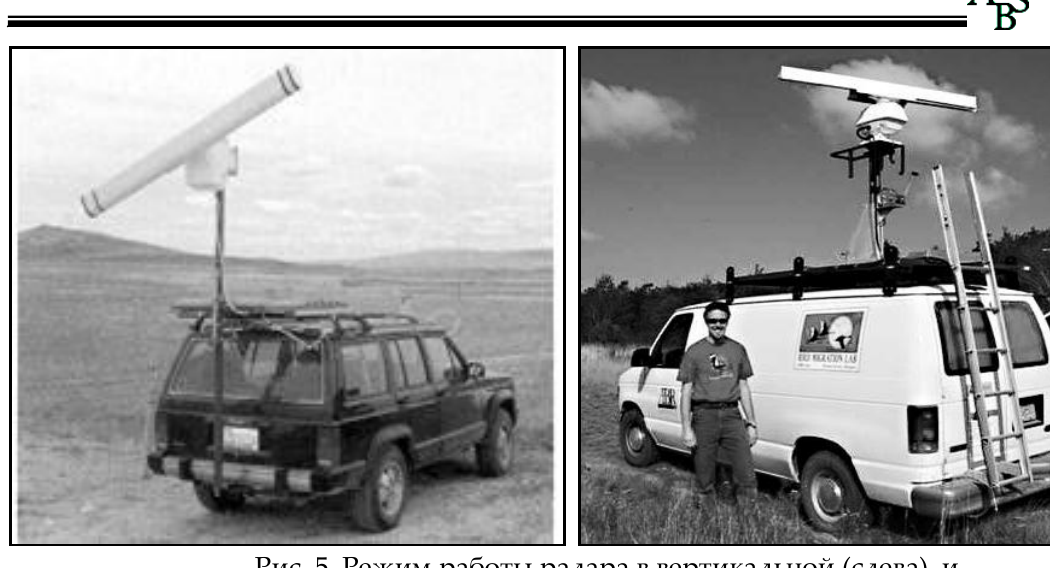
Рис . 5. Режим работы радара в вертикальной ( слева) и горизонтальной плоскости (из Harmata et al., 2003)